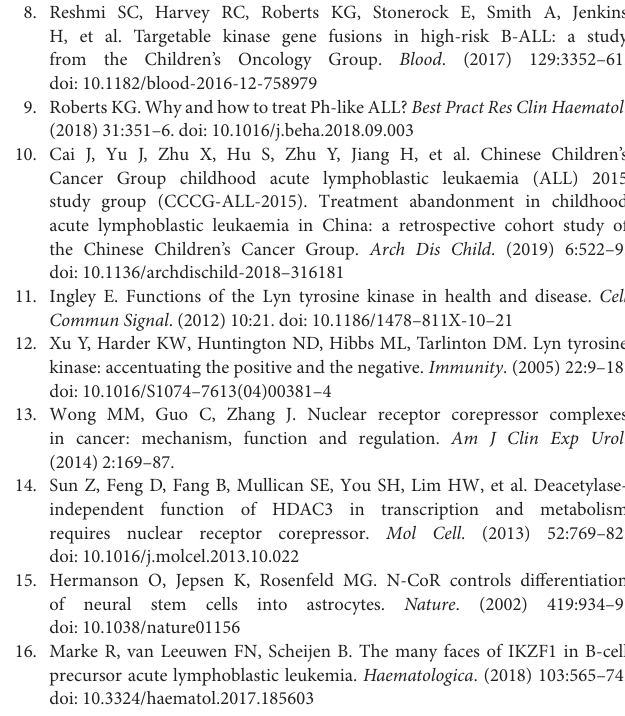
Supplementary Figure 1 | Timeline of the